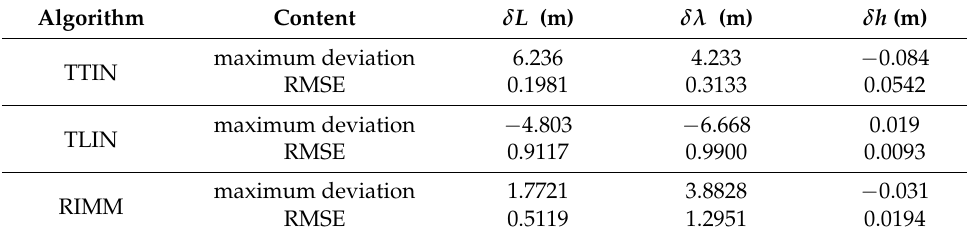
Figure 8. Position errors of three algorithms when DVL working properly. Table 3. Position error parameters for the three algorithms when DVL working